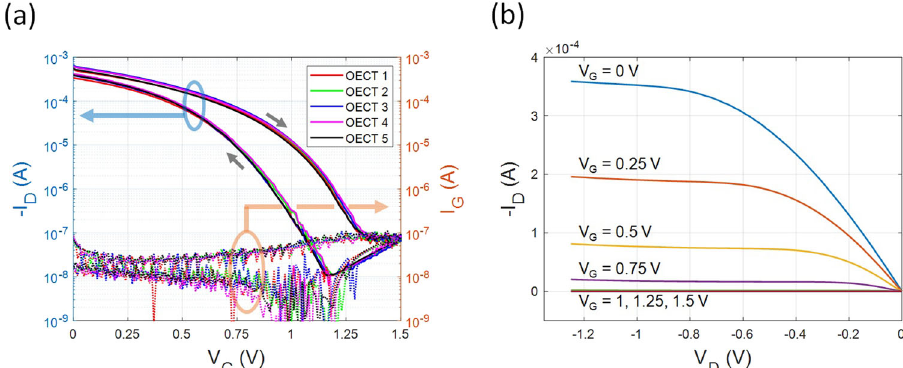
Fig. 3 OECT behavior. a Transfer sweep of a block of Small OECTs (including fi ve individual OECTs), b output curves of one Small OECT.